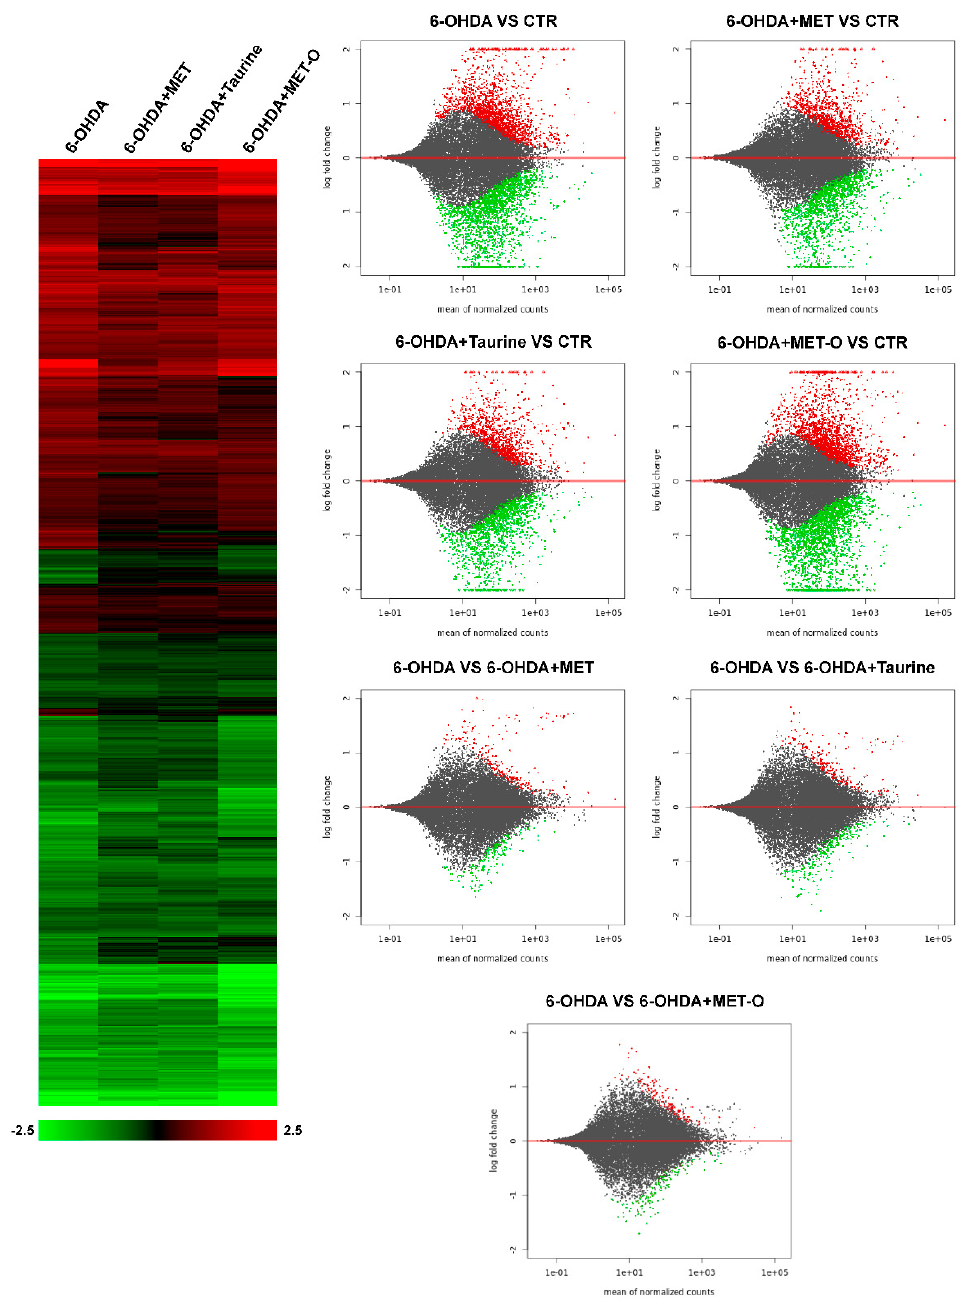
Figure 2. On the left, heatmap of hierarchical clustering (Euclidean metrics) of the 3175 genes whose expression is significantly perturbed by 6-OHDA (adjusted p < 0.05). Color scale represents log2 ratios of the expression levels in the indicated condition versus control. Color scale limits are indicated in the box below the heatmap. On the right, MA plots show up- and down-regulated genes in the different treatments (in red, the significantly upregulated genes; while in green, the downregulated).